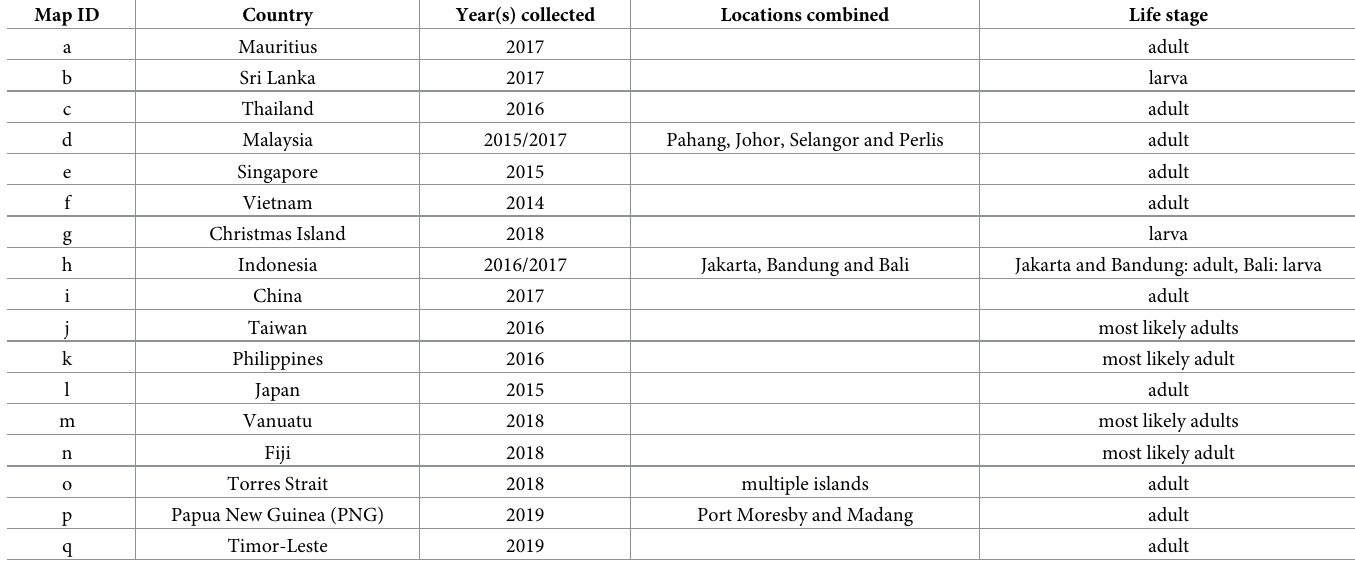
Table 1. Details of Aedes albopictus sampled from 17 populations. See Fig 1 for map ID locations. Map ID